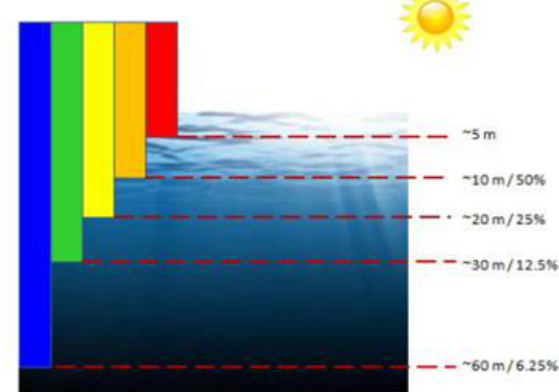
Figure 1. Infiltration of light in the water. [after Hitam et al. 2013]